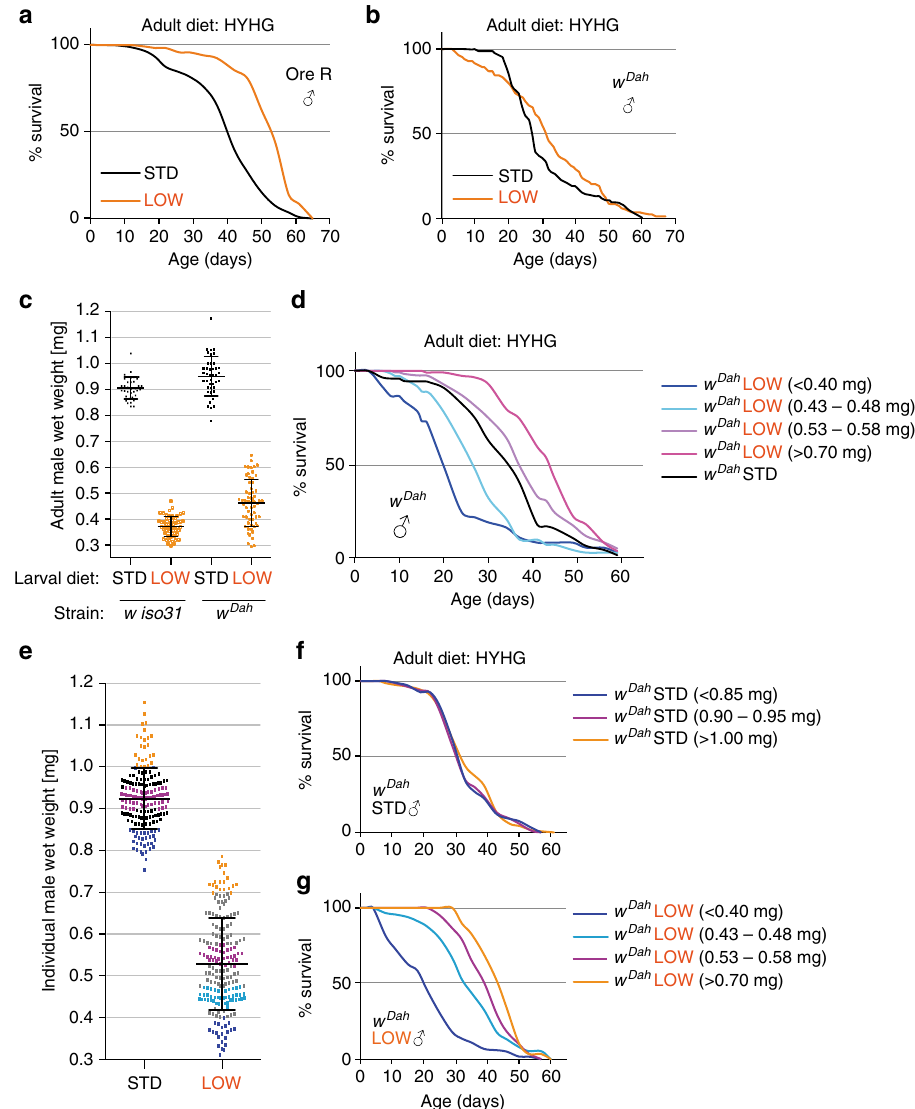
Fig. 2 Developmental diet regulates lifespan in heterogeneous genetic backgrounds. a , b Survival of STD and LOW adult males of Oregon R ( a , OreR) and white Dahomey ( b , w Dah ) strains. c Wet body mass of individual STD and LOW adult males at 1 week of age for the w iso31 and w Dah strains. d Survival on HYHG of w Dah LOW males separated individually into the four indicated weight bins compared to w Dah STD males. e – g Wet body mass at 3 days of age of individual STD and LOW adult males separated into coloured weight bins e used for survival curves on the HYHG adult diet f , g . Note that the weight bin in e and its representative survival curve, in f , g are indicated with the same colour. Error bars show ± 1